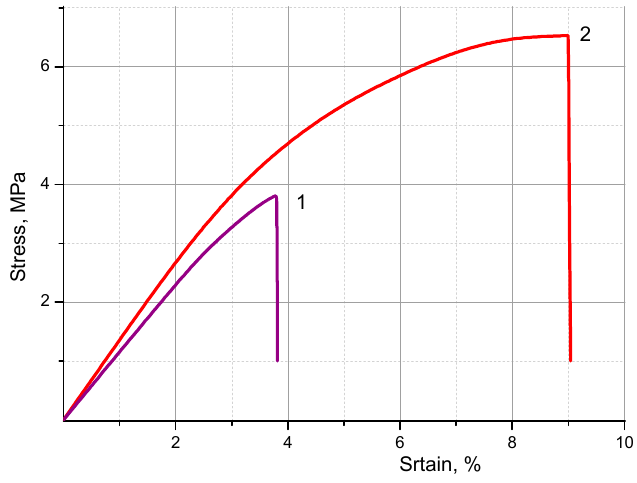
Figure 6. Stress–strain curves of ( 1 ) co-PAA and ( 2 ) co-PBOI membrane films.